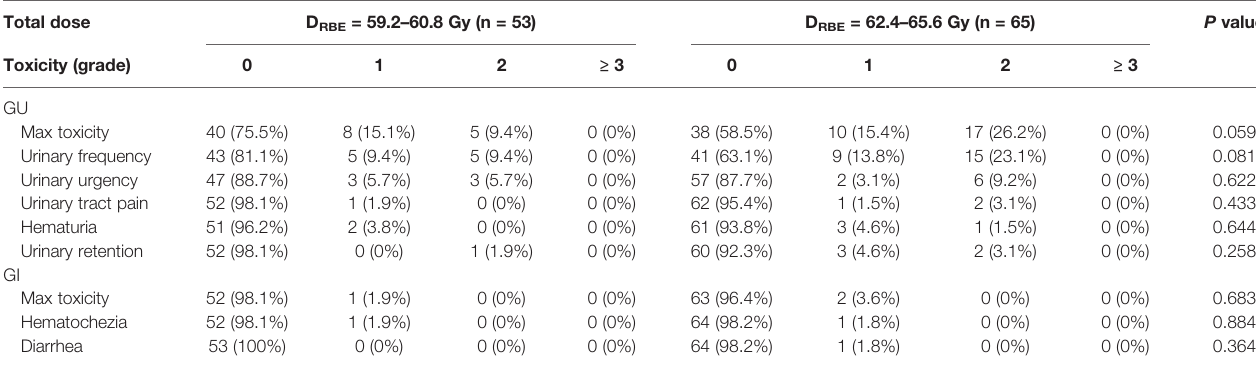
TABLE 2 | Acute toxicity between low-dose and high-dose groups. Total dose